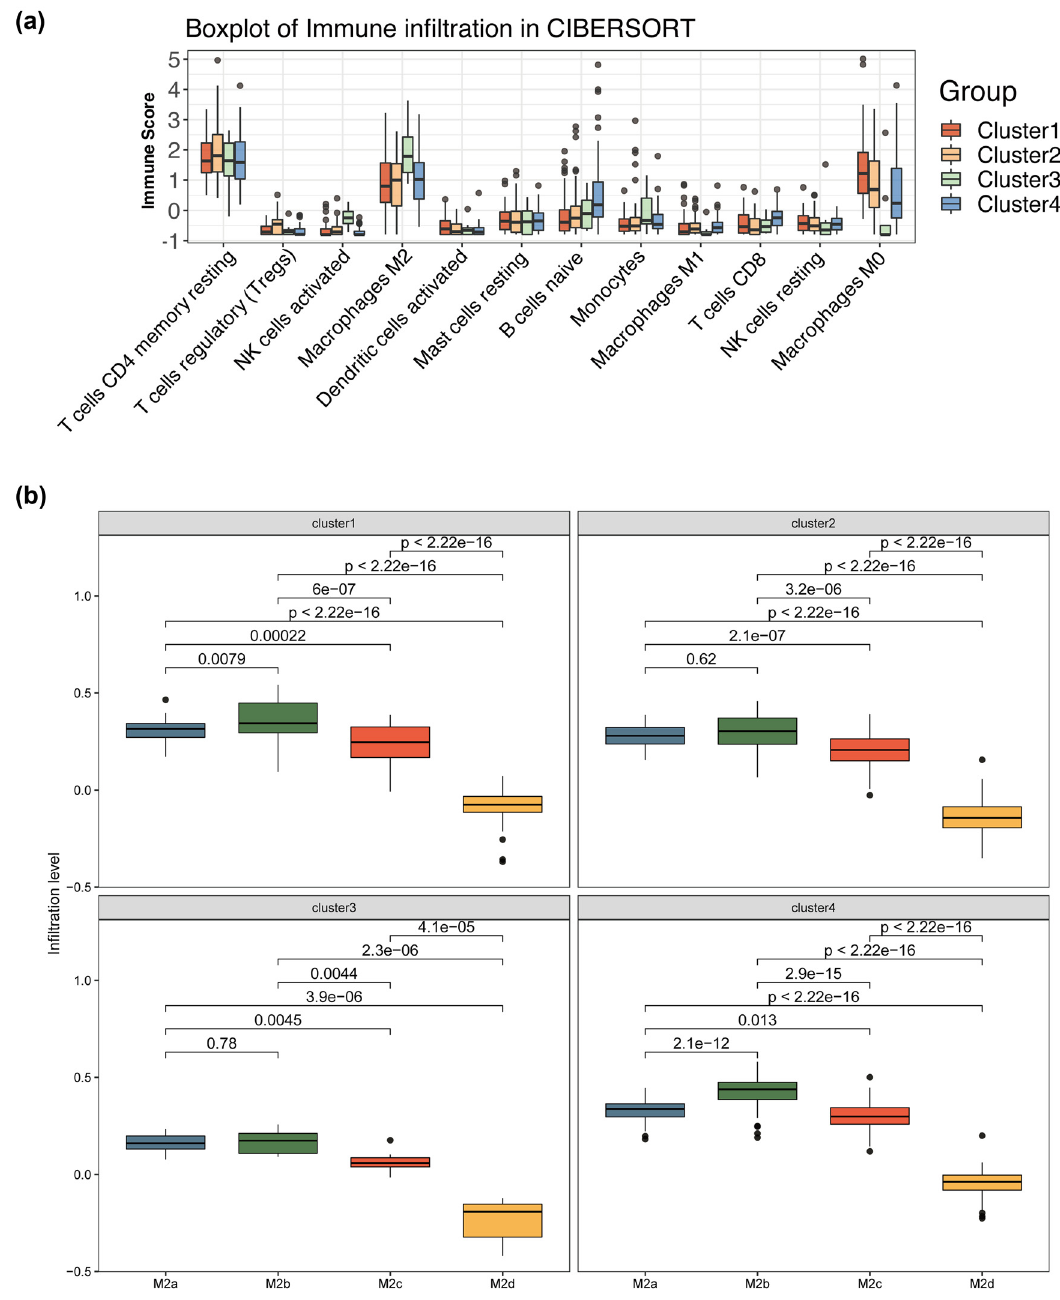
Figure 5: Analysis of the di ff erences in immune in fi ltration among subgroups: ( a ) immune scores of 12 kinds of immune cells in di ff erent subgroups; and ( b ) in fi ltration levels of M2a, M2b, M2c, and M2d in